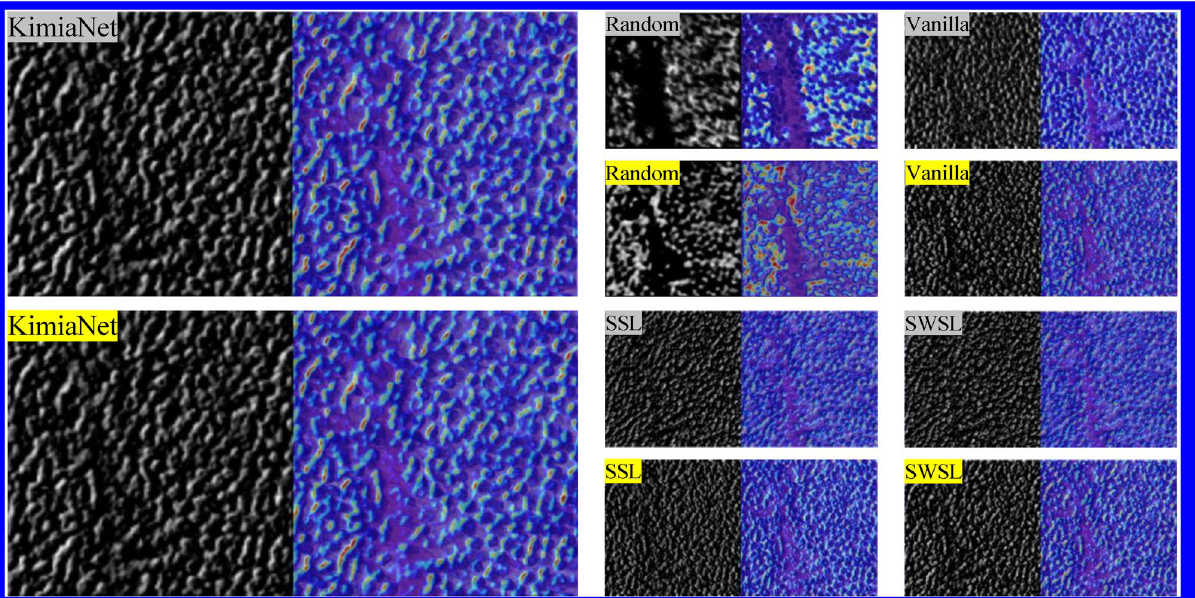
Figure 9. Activation maps of first layer weights: pre-trained weights (Gray-highlighted) and fine-tuning (Yellow-highlighted) using the same downstream task for each pre-training